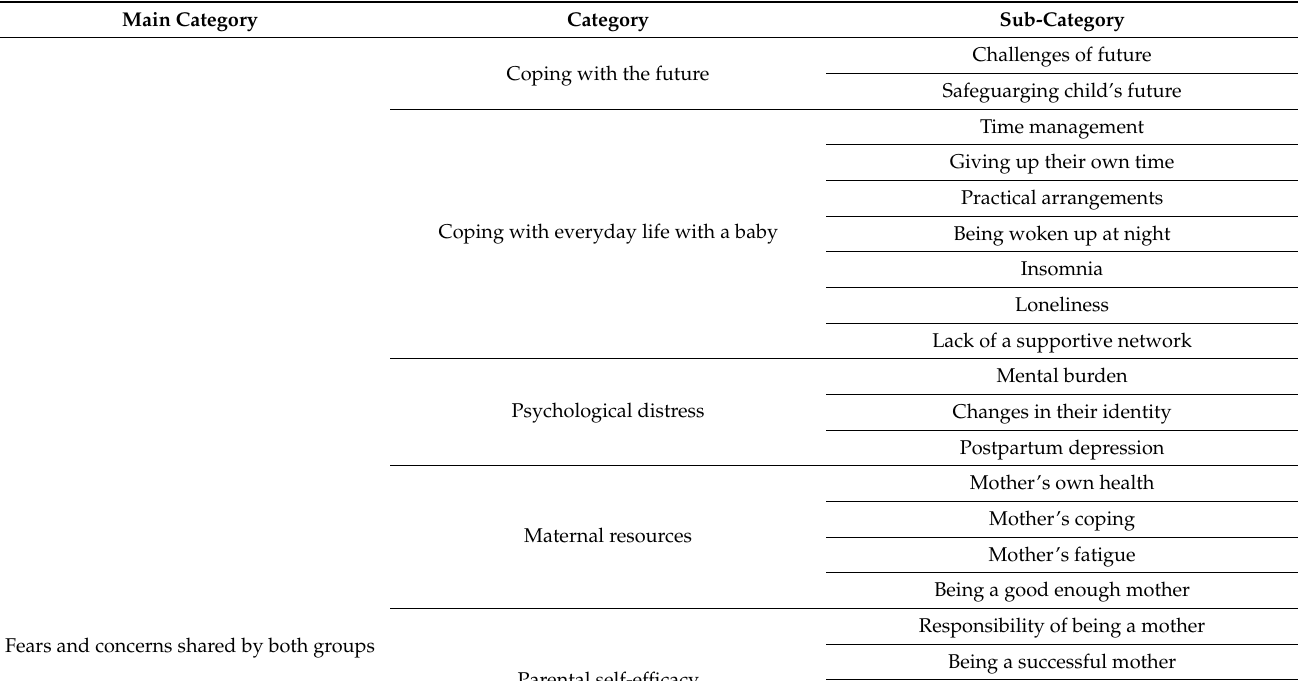
Table 2. Maternal fears and concerns related to parenthood during